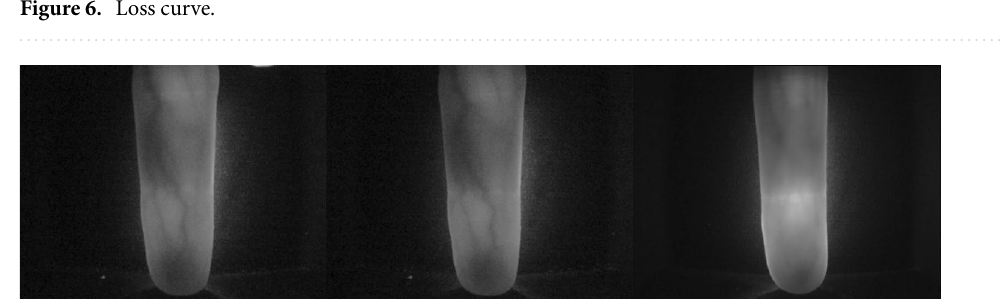
Figure 6. Loss curve.